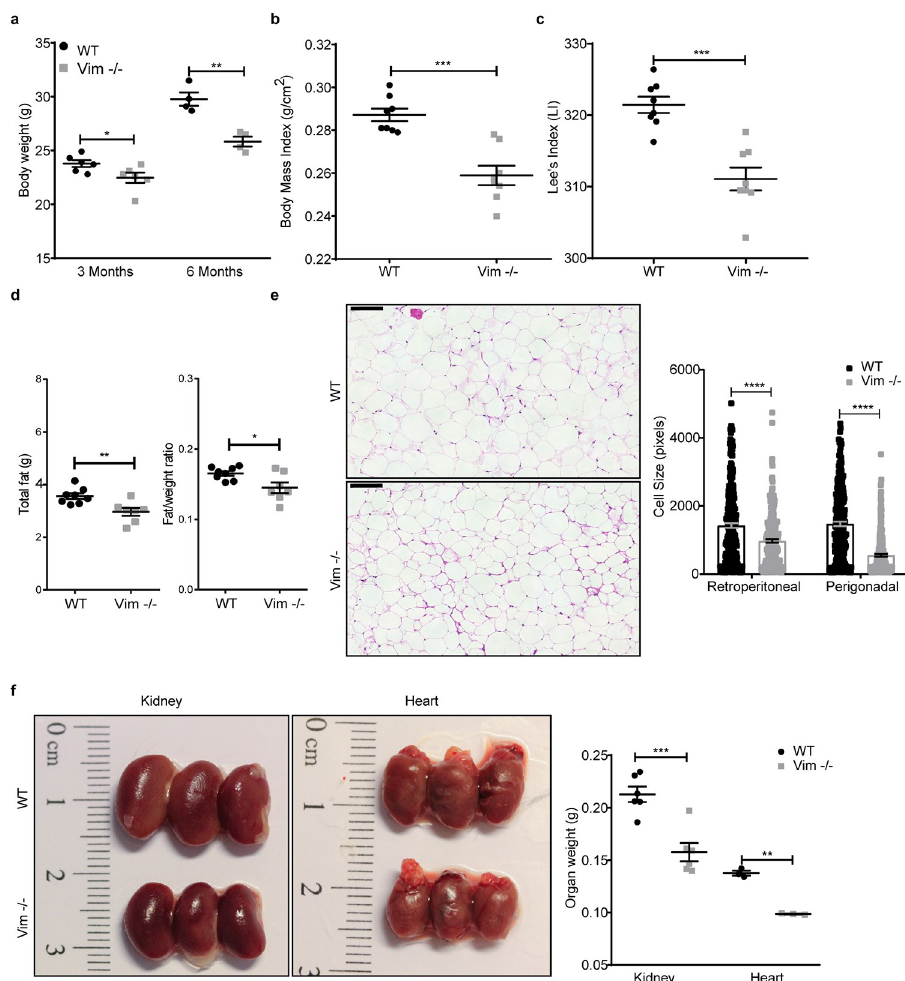
Fig 1. Vim − / − mice are smaller than WT. (a) Body weight of WT and Vim − / − male mice of 3 ( n = 6) and 6 months old ( n = 4). (b) BMI and (c) Lee’s indexes were calculated for 6 months old mice ( n = 8). (d) Total fat mass determined by EcoMRI and ratio of fat/weight of 6 months old male mice ( n = 7–8). (e) Micrograph of adipocytes from 3 months old WT and Vim − / − male mice. The size of retroperitoneal and perigonadal adipocytes were quantified using Fiji ( n = 3, 250 cells in total). (f) Organ weight of kidney ( n = 6) and heart ( n = 3) from 3 months old male mice. The results are presented in the form of mean ± standard deviation of the mean of the biological replicates. Scale bar = 100 μ m, � p < 0.05; �� p < 0.01, ��� p < 0.001, ���� p < 0.0001. The data underlying the graphs shown in Fig 1A–1F can be found in S1 Data.